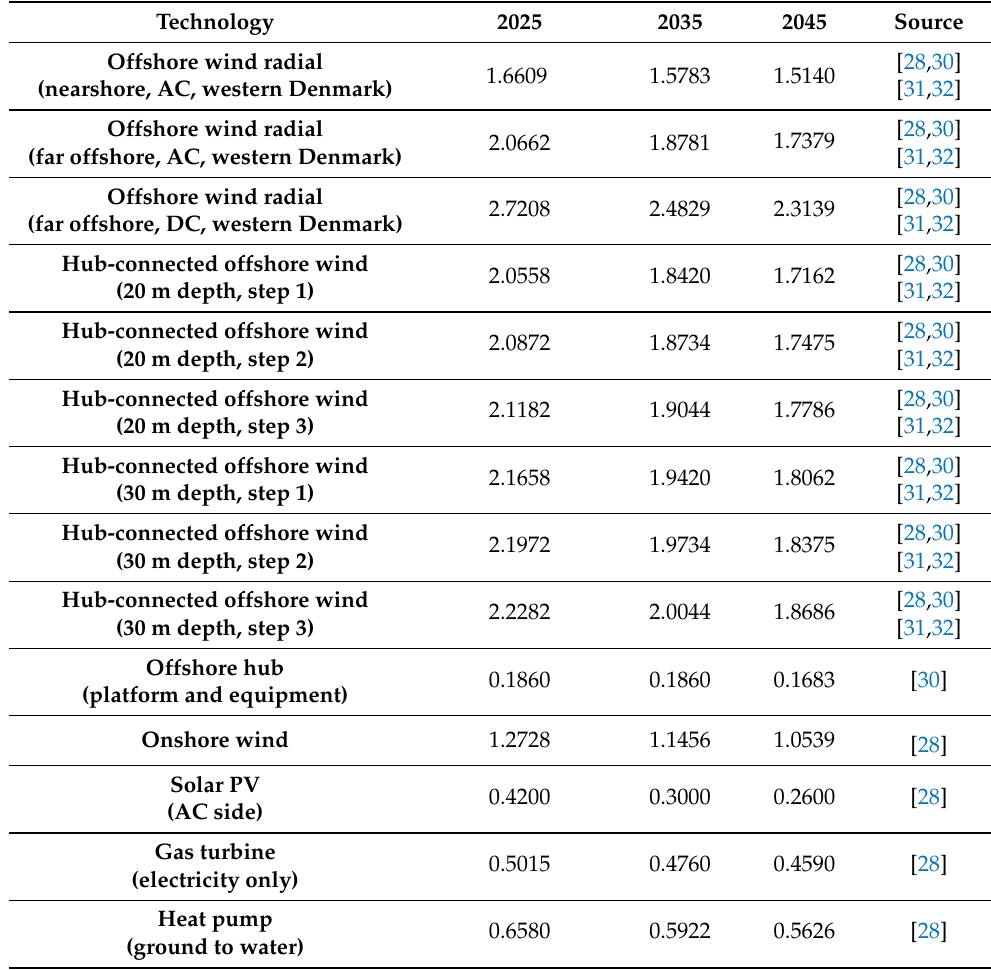
Table 1. Development of investment costs for selected large-scale key technologies in M e 2016 /MW (M e 2016 /MWh for storage). Additional costs, such as variable fixed costs or operational fixed costs, are not shown, but can be accessed in [27]. The costs presented for electrolyzers and fuel cells are defined on the electric